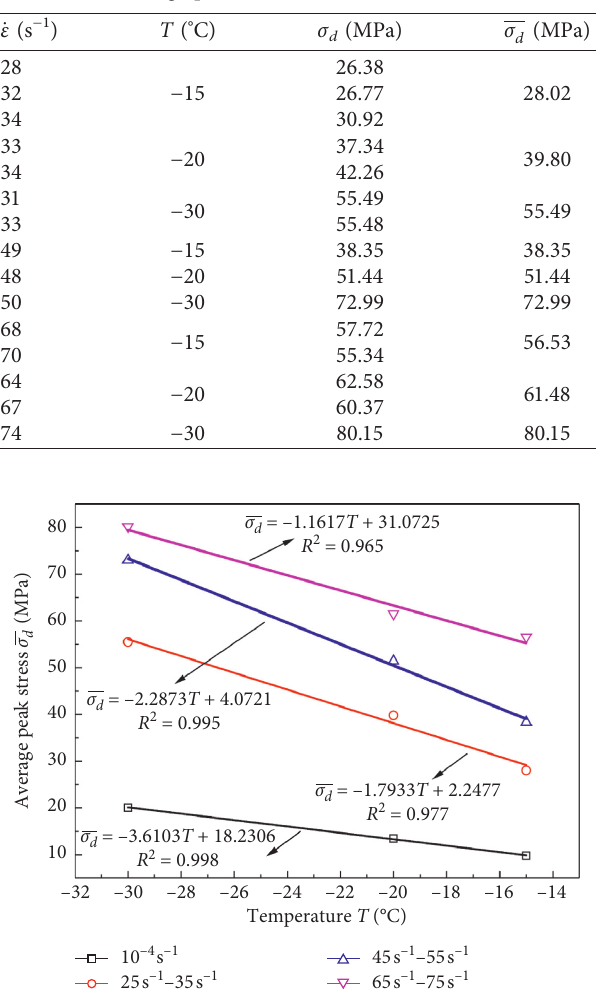
Figure 7: Relationship between the average dynamic peak stress and the